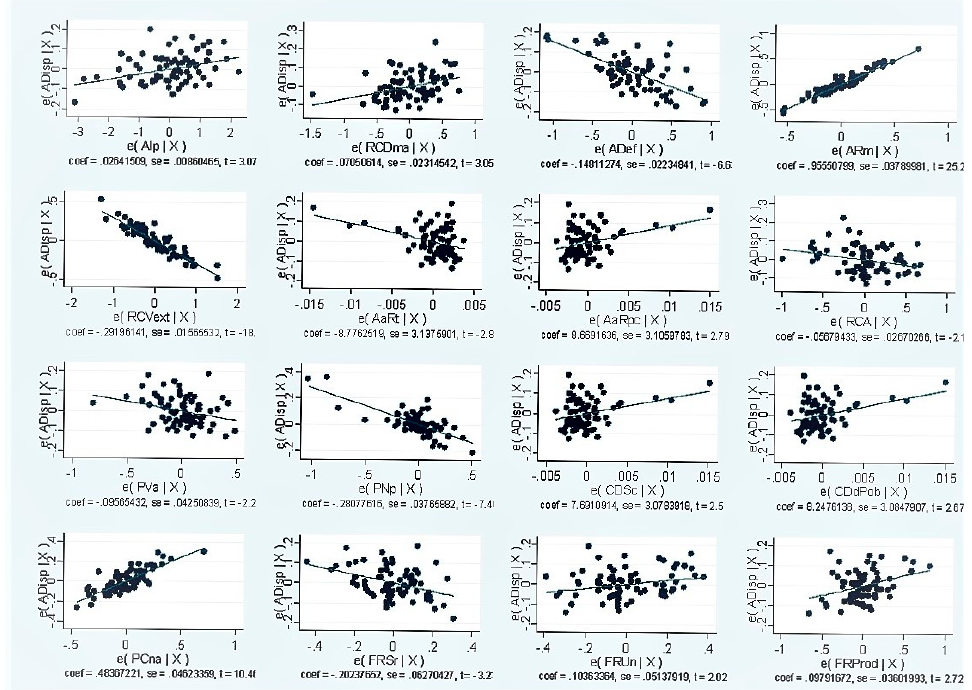
Figure 7. Partial regression graph for each of the independent variables.